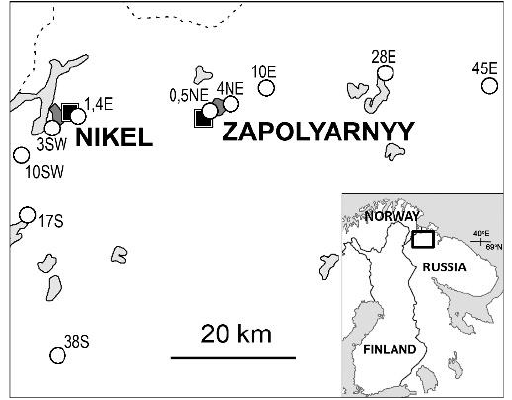
Figure 1. Location of the study sites (circles) in the vicinity of the Nikel copper–nickel smelter and the Zapolyarnyy ore-roasting factory (black squares). The site codes indicate the approximate